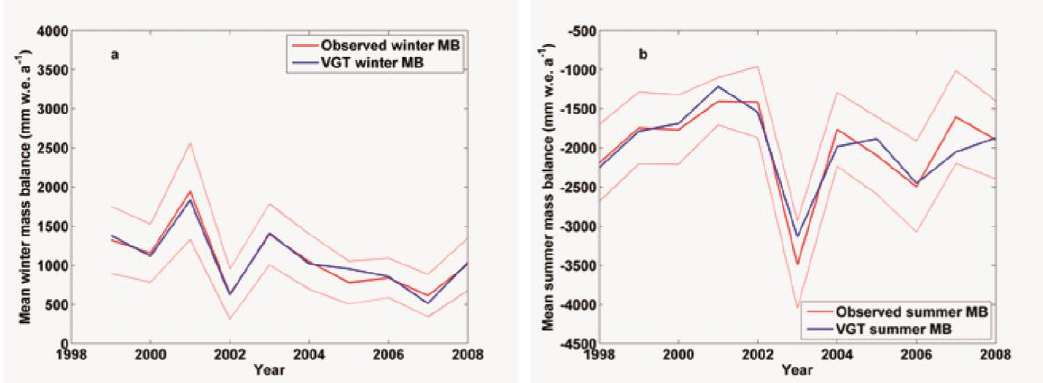
Figure 11. Time series of observed SMB (red) and VGT SMB (blue) over the period of 1998–2008, averaged for the 55 glaciers. The pink curves represent the ± 1 standard deviation for all glaciers. ( a ) Winter SMB; ( b ) summer SMB. From Drolon et al. [51].